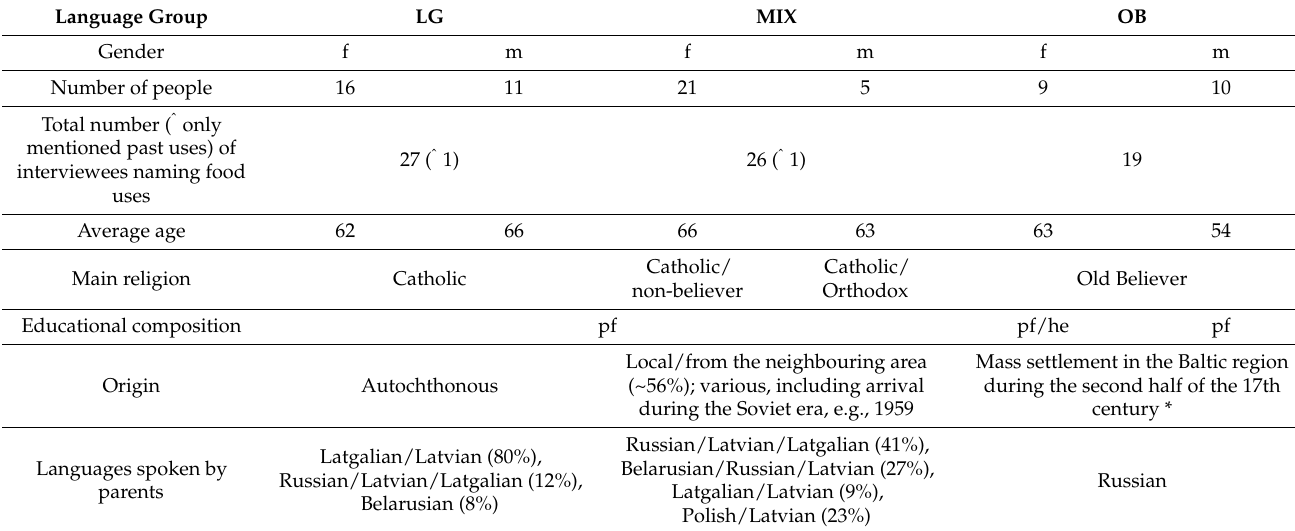
Table 1. Information on the